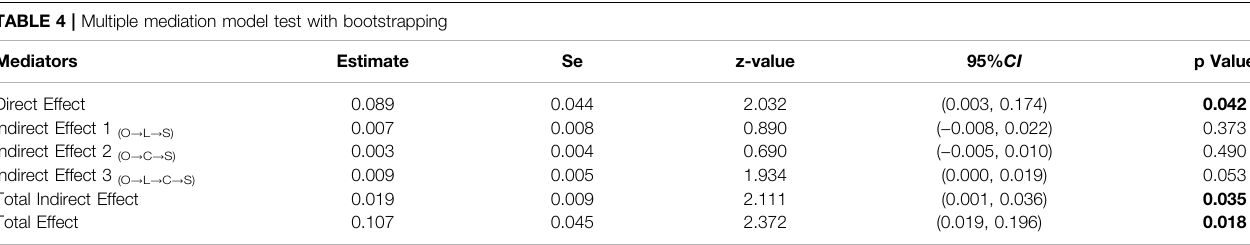
Table 4 presented the standardized path coef fi cients for the effects of OXTR rs2254298 on SWB in the mediation model. When both genotype and the context/luck attribution were included as